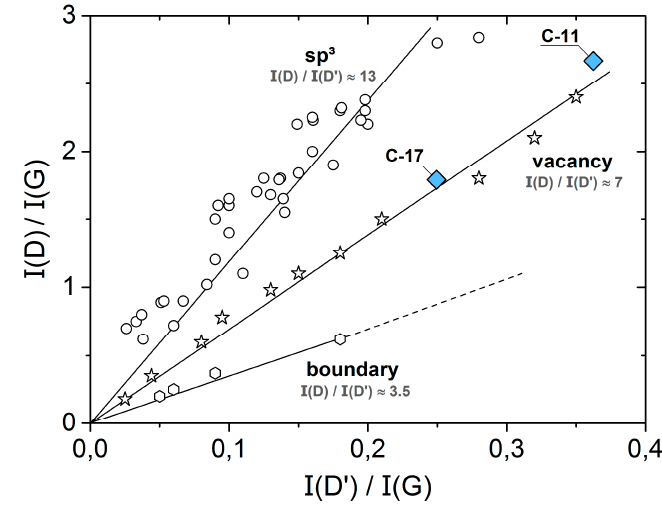
Figure 5. I D /I G versus I D’ /I G -plot. Open symbols: ref. [44].